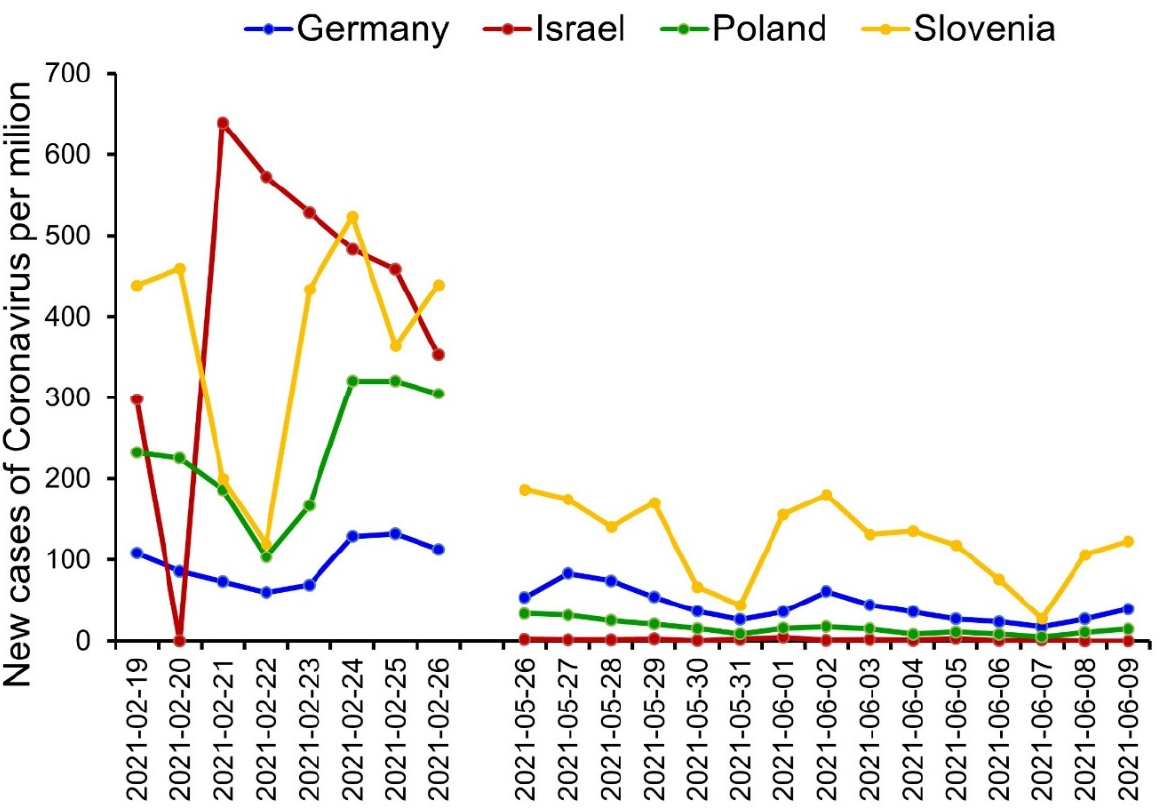
Figure 1. Number of new cases of COVID-19 infections per million citizens in four countries (Ger- many, Israel, Poland, and Slovenia) during the data collection in T1 (19–29 February 2021) and T2 (26 May–9 June 2021). Source: Johns Hopkins University Center for Systems Science and Engineering (CSSE) COVID-19 Data [24].